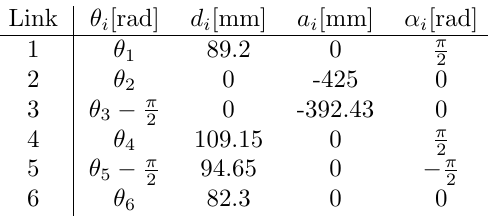
Table 2: DH-table for the UR5